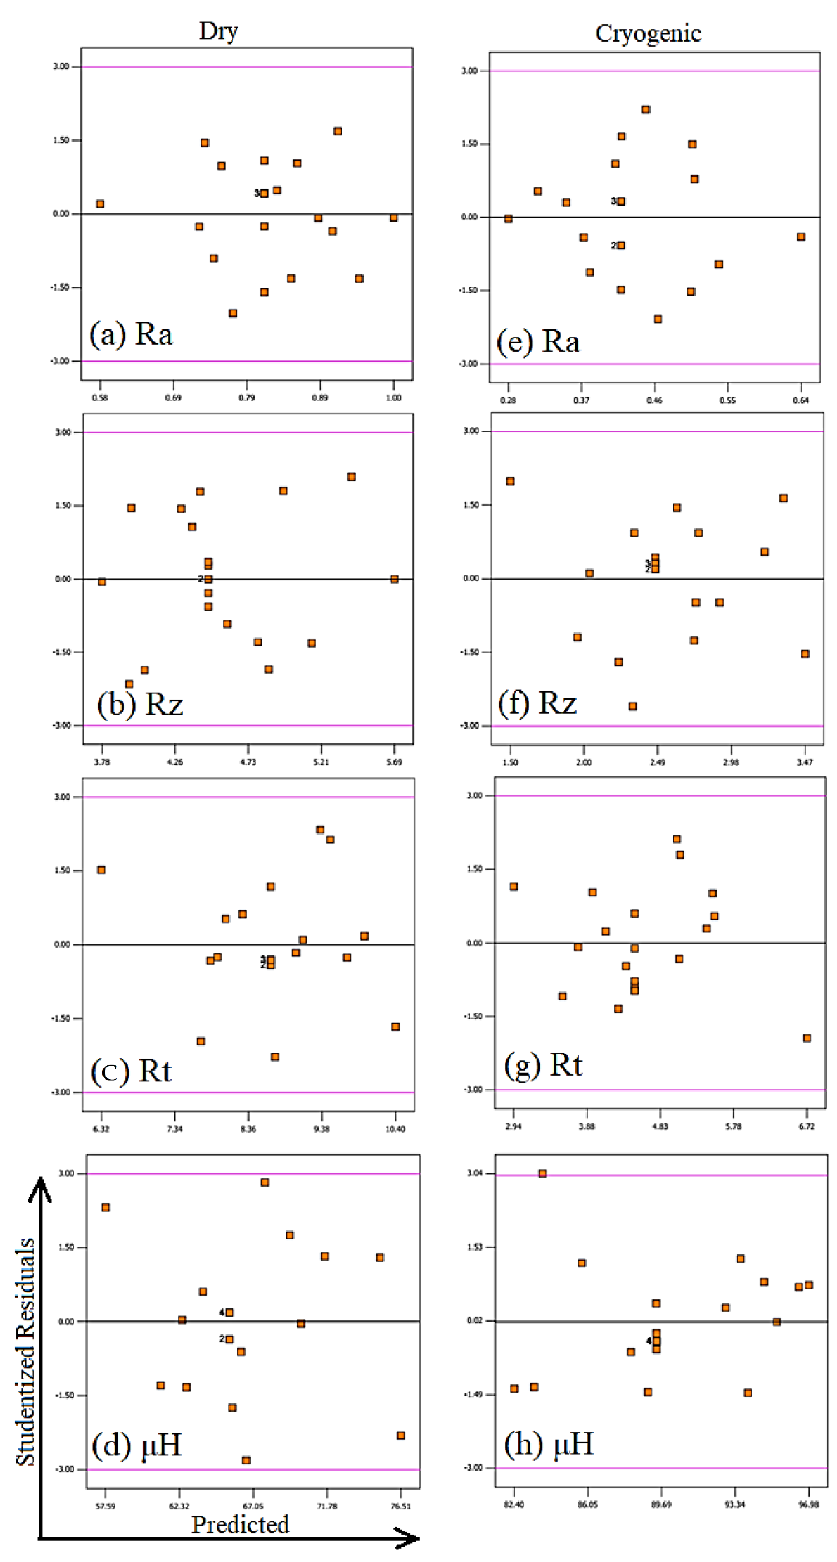
Figure 4. Residuals vs. predicted plots of all the developed models for turning AZ31 Mg alloy.